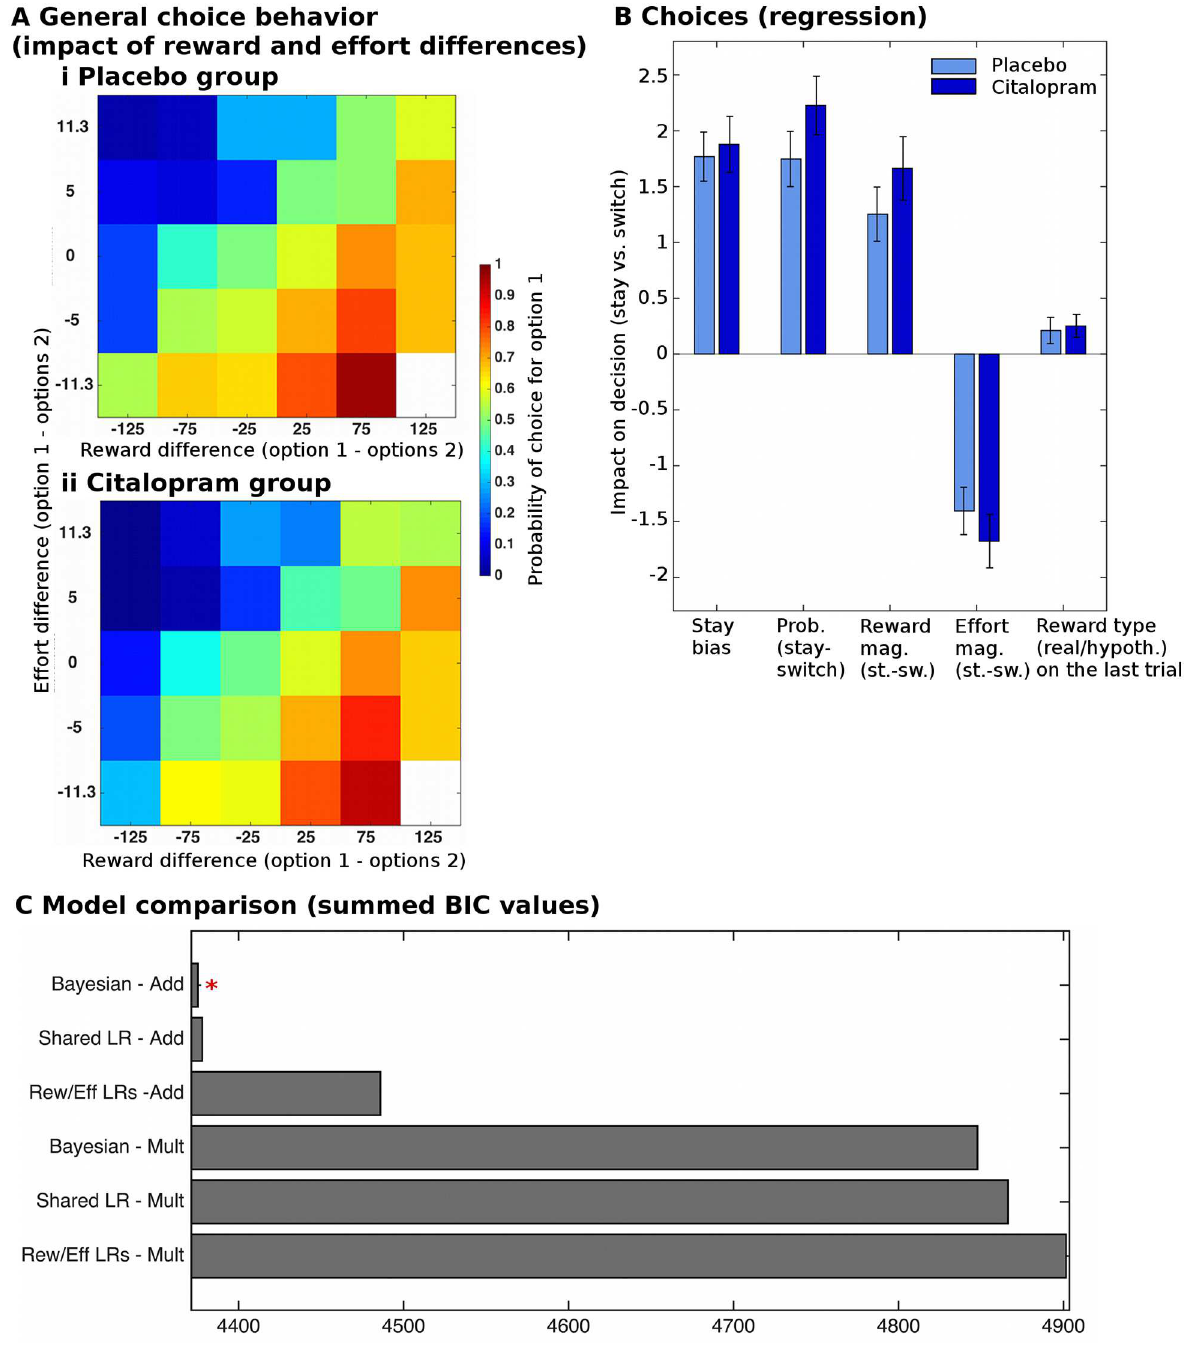
Fig 2. Task validation and model comparison. (A) The choices of participants in both groups(i, ii), betweenoption one and option two, were guidedby the learnt rewardand effort differences betweenthe options(estimated from a Bayesianmodel). They were more likely to choose the optionwith higherrewardand lower effort magnitudes. (B) Regressionanalysis(bGLM1) predictingwhetherparticipants selectedthe same optionagain as on the last trial (“stay”) or selectedthe alternativeoption (“switch”). Participants took all relevant features of the task into account: they were more likely to choose optionsthat had a higherdisplayedprobability, higherlearnt reward, and lower effort magnitudes (all p < 10 − 8 ; no group differences, all p > 0.2; omnibusANOVA includingregression weights for probability,learnt rewardand effort also revealed no group difference: F(1,27) = 2.3, p = 0.14). Participants were also more likely to choose an option again if they had receiveda real rewardon the last trial (t(28) = 3.04, p = 0.005). There was no difference betweenthe groups in the overall amount of money earned. (C) Model comparisonusing summed BayesianInformation Criterion (BIC) values revealedthat models